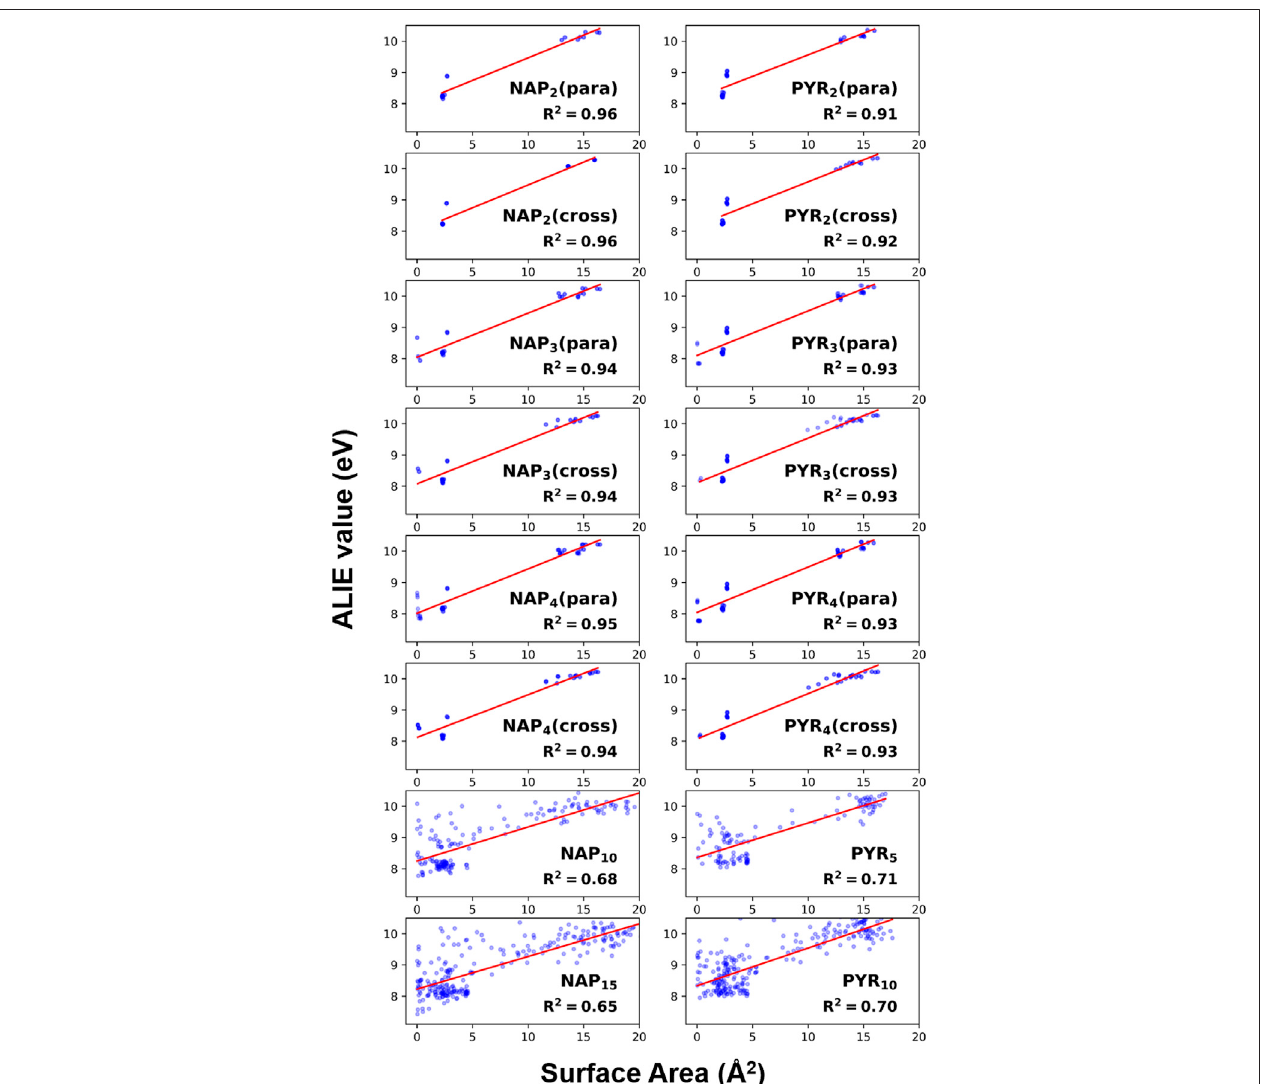
FIGURE 8 | The correlation of ALIE values with surface area of each atom. The red lines represent linear fi ttings, and the fi tting quality is illustrated by R 2 shown in the plots.